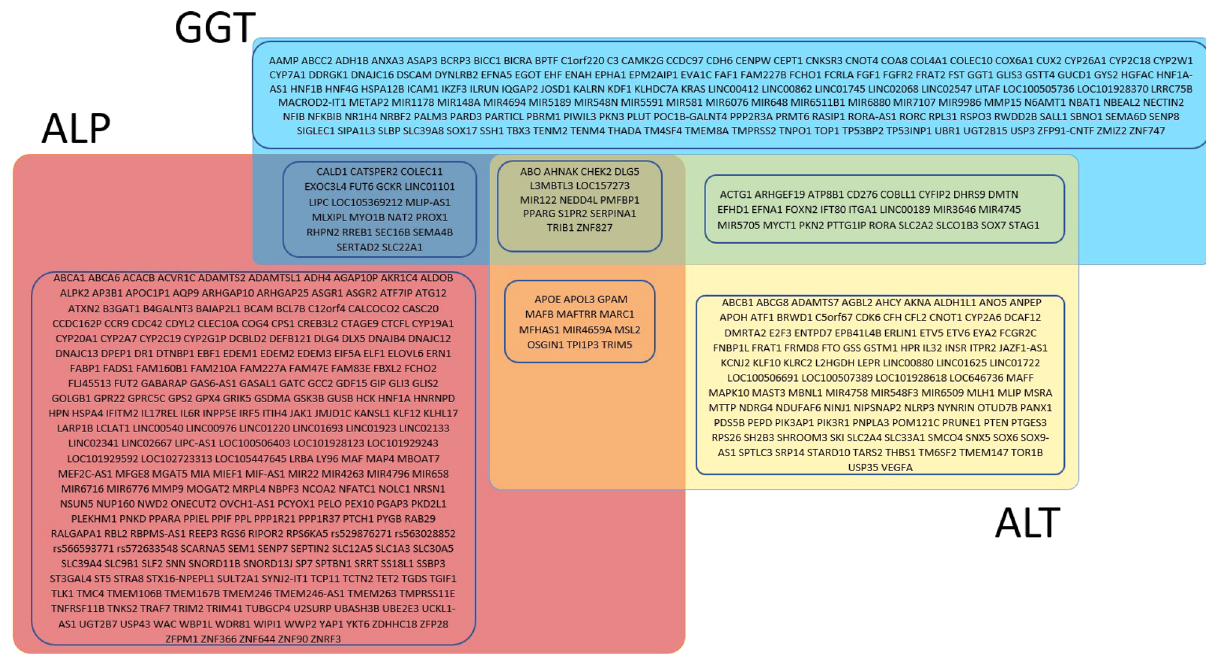
Fig. 3 Overview of nearest genes mapped to known and novel ALT, ALP, and GGT replicated SNPs and their overlap. Yellow box depicts replicated genes mapped to ALT. Red box depicts replicated genes mapped to ALP. Blue box depicts replicated genes mapped to GGT. Boxes in overlapping sections depict genes identi fi ed to be associated with more than one liver